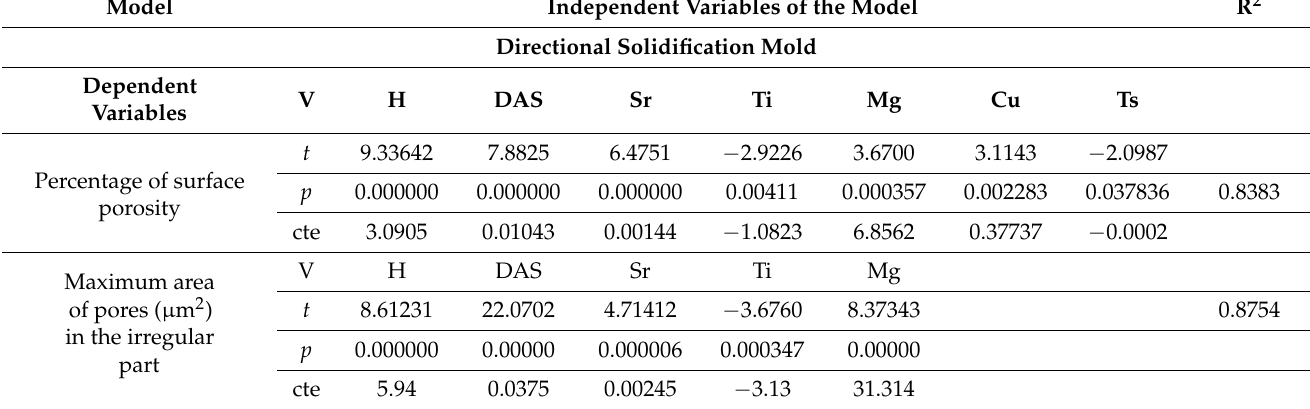
Table 3. Independent variables used for the description of the different models for the directional solidification